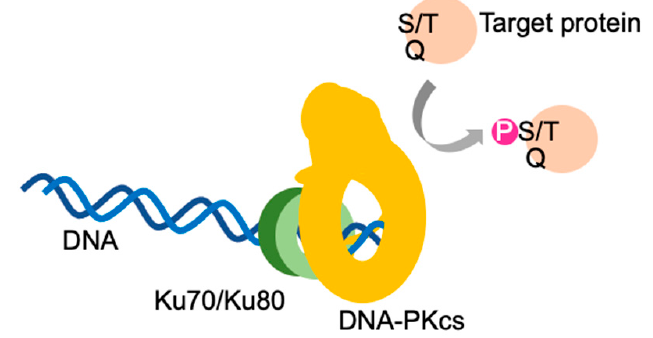
Figure 1. DNA-dependent protein kinase. DNA-PK holoenzyme consists of a DNA-dependent protein kinase catalytic subunit (DNA-PKcs), the Ku complex (Ku70/Ku80) and double-stranded DNA. DNA-PKcs acquires kinase activity in the presence of the Ku complex and double-stranded DNA. DNA-PK holoenzymes preferentially phosphorylate the serine (S) and threonine (T) of serine /glutamine (Q) and threonine/glutamine motifs in target proteins.